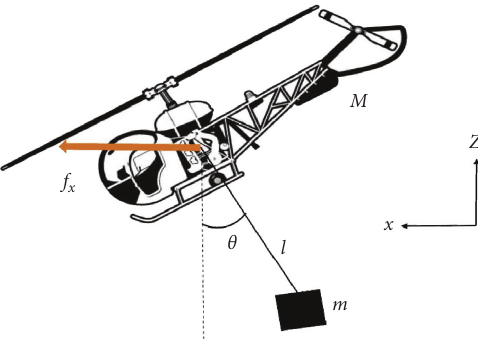
Figure 1: The straight line motion of the suspension cable system of the unmanned helicopter with single point